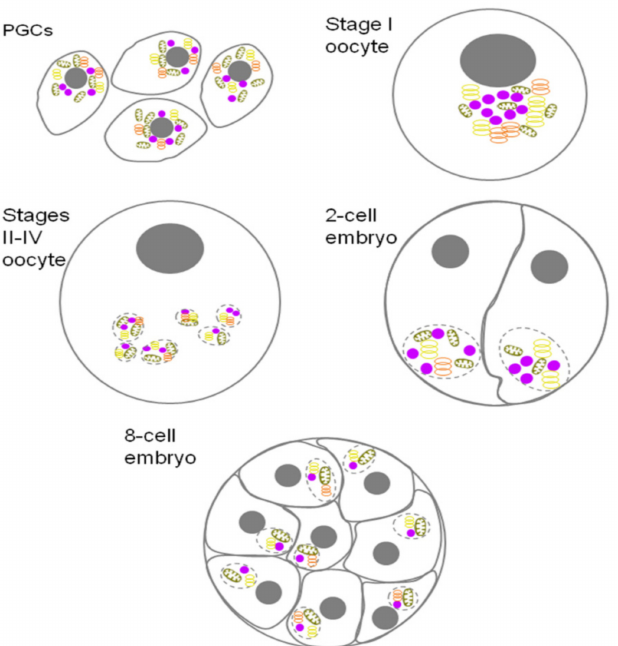
Figure 3. The Balbiani body (Bb) through Xenopus oogenesis. In late blastula and gastrula, PGCs are detectable within the embryonic endoderm. The PGCs (PGCs in the image) contain nuage nearby nuclei and mitochondria. During oogenesis, beginning from Stage (I) (shown in the image), a spherical structure that is in contact with the oocyte nucleus and mitochondria is revealed—the Bb [142]. During stage I and the transition into stage (II), the oocyte is arrested in the diplotene of meiosis I. During the subsequent progression through oogenesis, there is a phase of massive growth to accommodate the accumulation of yolk and synthesis of proteins and RNAs, as well as a rearrangement of cytoskeleton. Stages II–IV, shown in the drawing—between stages II and IV of oogenesis, the Bb is divided into ‘islands’ that move towards the vegetal cortex. ‘Islands’ anchored at the top of the vegetative pole of stage VI oocytes are called ‘germplasm islands’. With the onset of embryonic development, at the 2-cell stage, the comonents of the ‘islands’ are divided between the blastomeres of the vegetative pole (‘2-cell embryo’ in the drawing). After fertilization and during early cleavages, ‘germplasm islands’ coalesce into larger aggregates at the vegetal apexes of vegetal blastomeres. (‘8-cell embryo’ in the drawing’). Later, the islands are fragmented again and split between the PGCs. When the PGCs move towards the gonadal bud, the islands substance changes localization to perinuclear, giving rise to nuage. The GG and germ plasm islands are fragmented again and segregate into blastomeres. Germ cells are outlined with grey, nuclei are shown as closed grey circles. Germ granules (closed purple circles). Mitochondria (brown ellipse). Endoplasmic reticulum (ER) (orange rings). Golgi (yellow rings). Germplasm islands are highlighted by a dashed line. Some stages are omitted for better